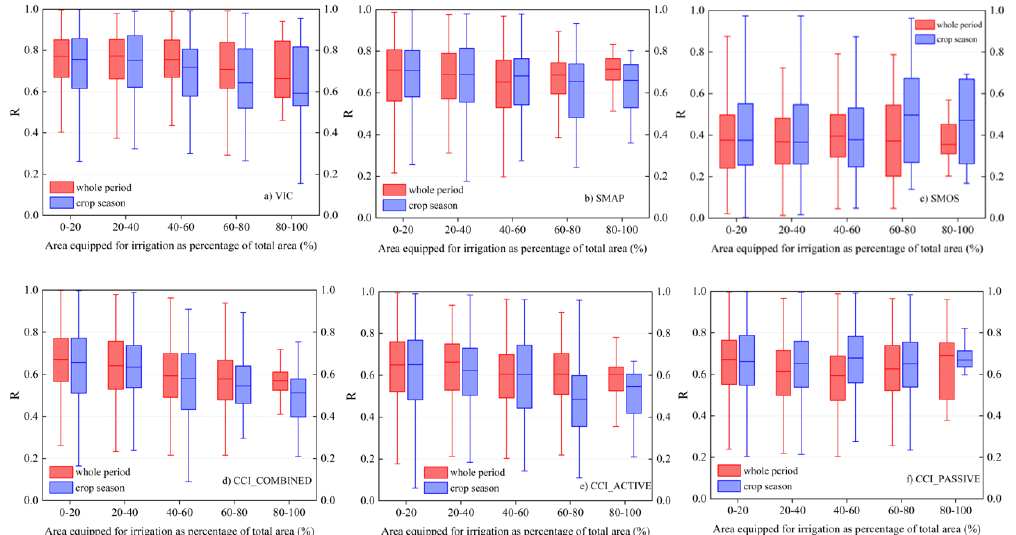
Figure 8. Boxplots of R for ( a ) VIC, ( b ) SMAP, ( c ) SMOS, ( d ) CCI_COMBINED ( e ) CCI_ACTIVE, and ( f ) CCI_PASSIVE soil moisture products over the whole validation period (31 March 2015 to 3 June 2018) and over the crop season (October to May of the following year) with di ff erent percentages of irrigated area. Note that R values of VIC, CCI_ACTIVE, CCI_PASSIVE are obtained via